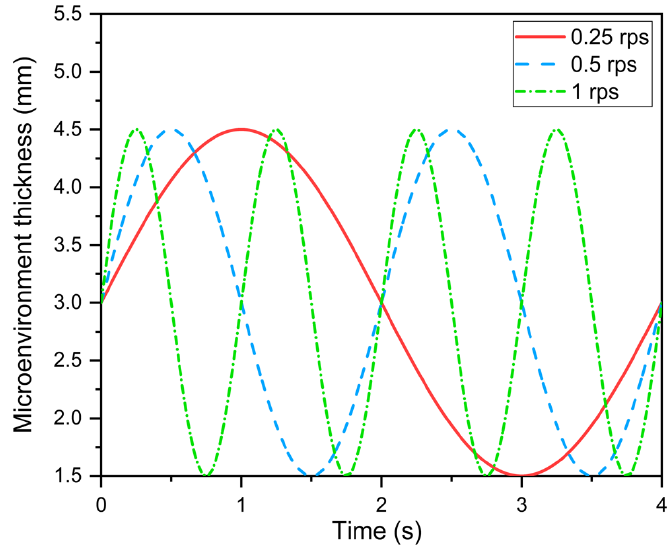
Figure 3. Sinusoidal variation of the microenvironment thickness.